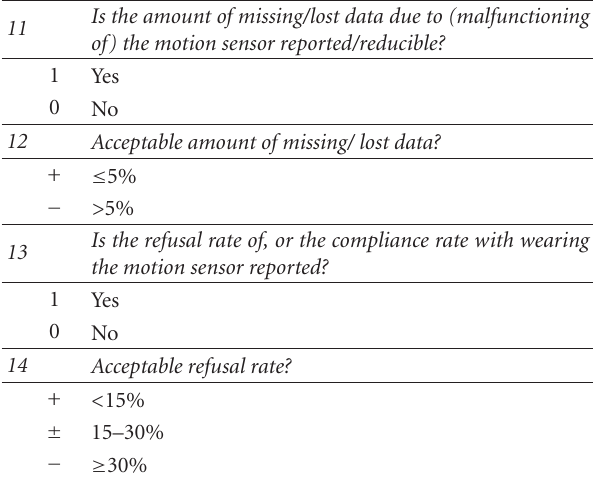
Table 3: Items concerning validity. Table 4: Items concerning